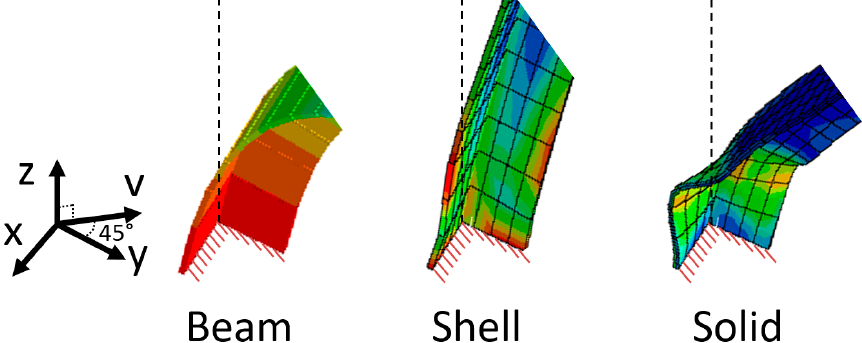
Figure 5. Local deformation shown at the beam’s fixed end. (Color from blue to red represents the value of equivalent stresses from low to high).